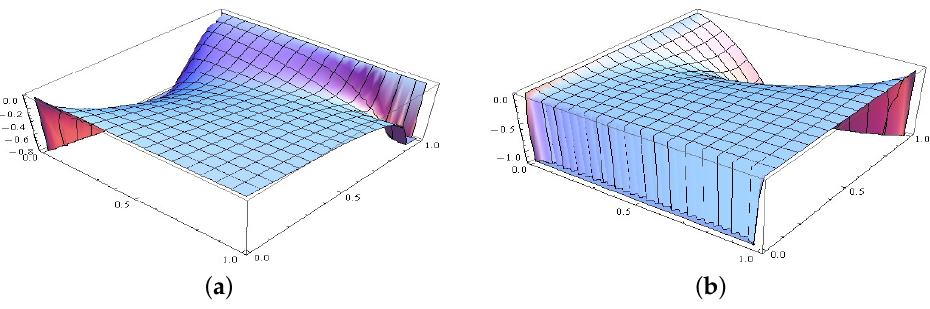
Figure 2. Surfaces of second-order derivatives. ( a ) ∂ 2 C θ ( u , v ) / ∂ u 2 ; ( b ) ∂ 2 C θ ( u , v ) / ∂ v 2